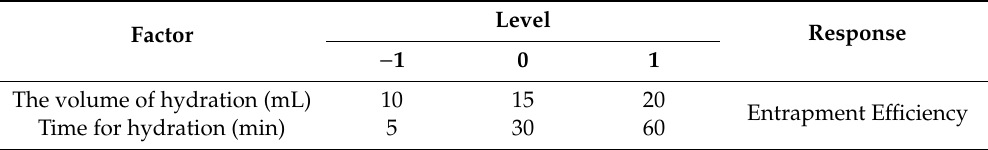
Table 1. Three-level factorial design for optimization of hydration